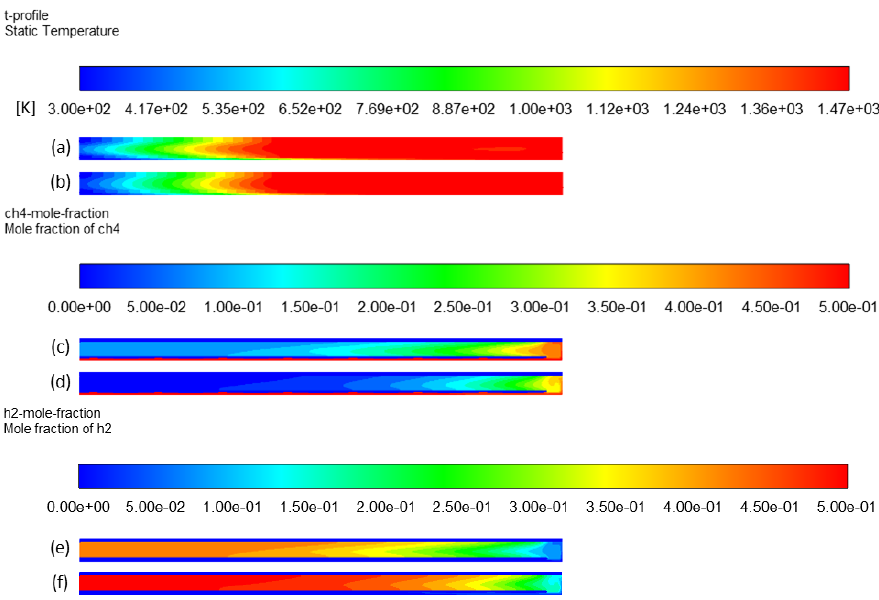
Figure 10. Effect of residence time on temperature profile: ( a ) case 3 and ( b ) case 1; CH 4 mole fraction profile: ( c ) case 3 and ( d ) case 1; H 2 mole fraction profile: ( e ) case 3 and ( f ) case 1.